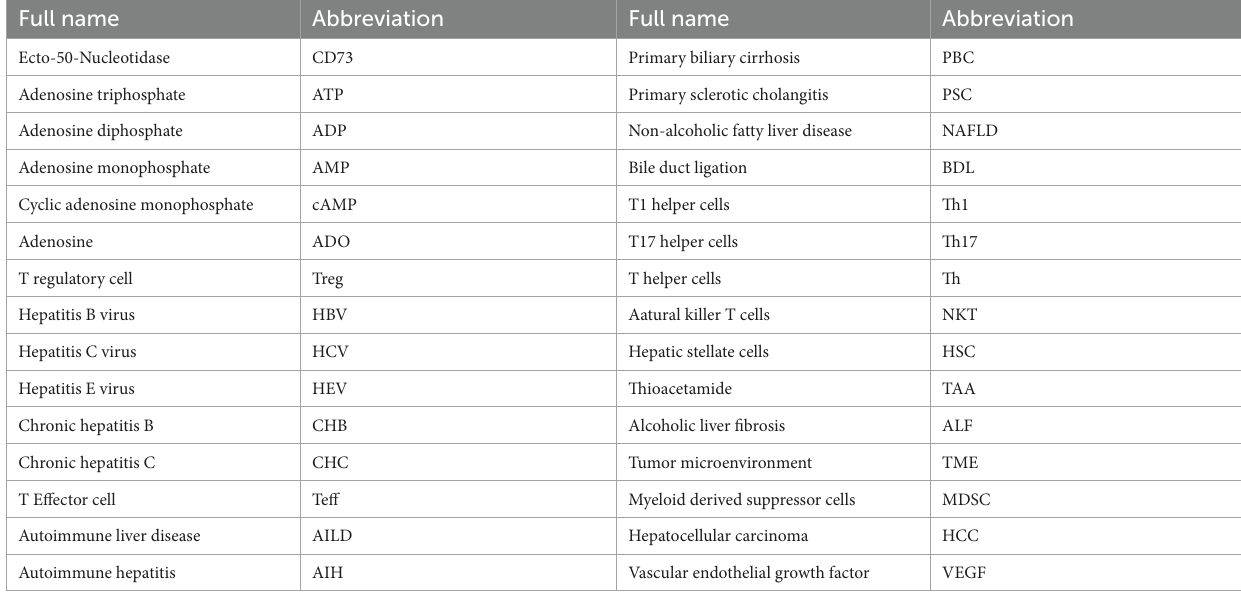
TABLE 1 English abbreviation comparison